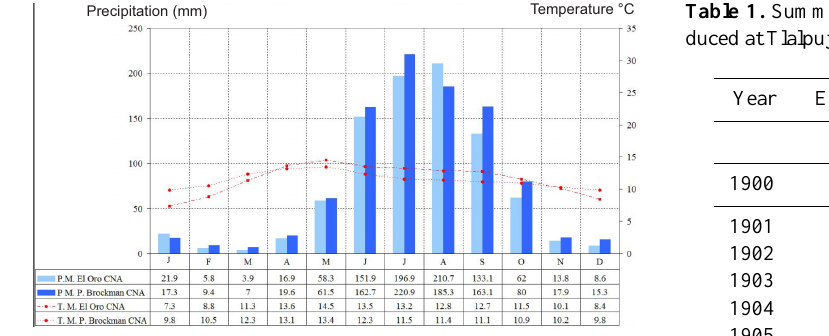
Figure 2. Annual precipitation and temperature data recorded at the meteorological stations in El Oro (15183) and Presa Brockman (15070) of the Comisión Nacional del Agua (CNA).